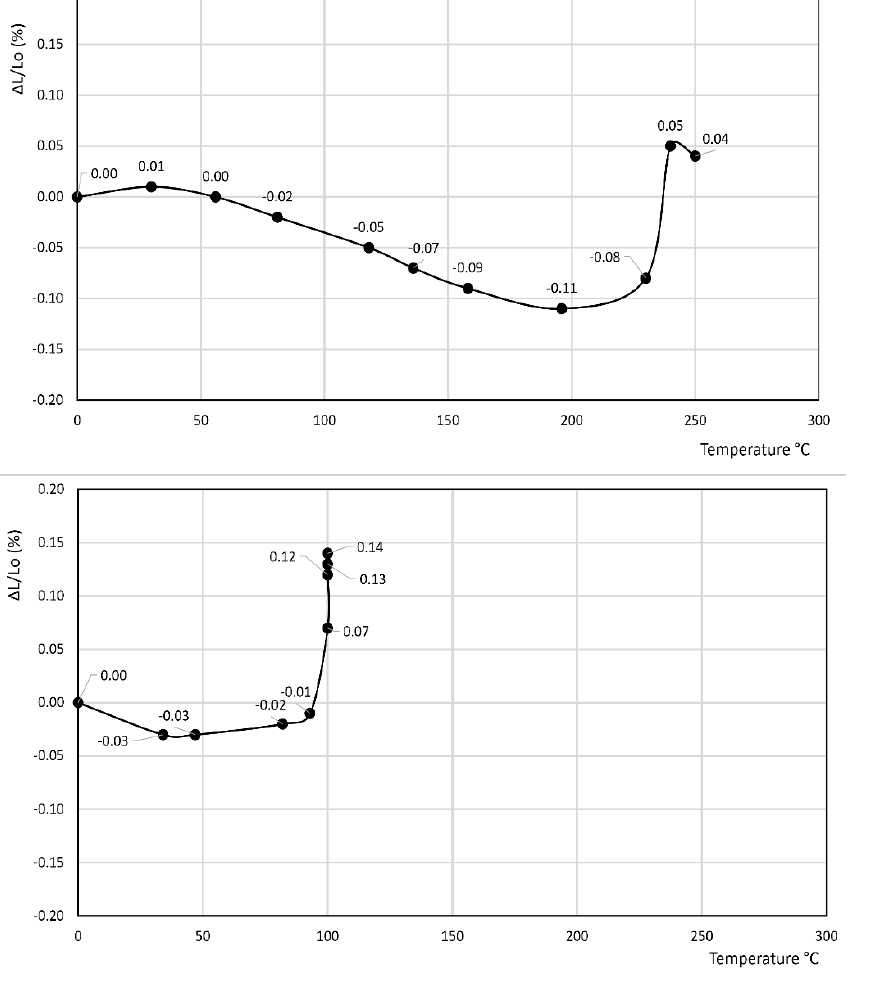
Figure 8. Thermodilatometric curve of the cylindrical specimen directly cut from the plaster recorded at 10 °C/min ( top panel) and 5 °C/min ( bottom panel).